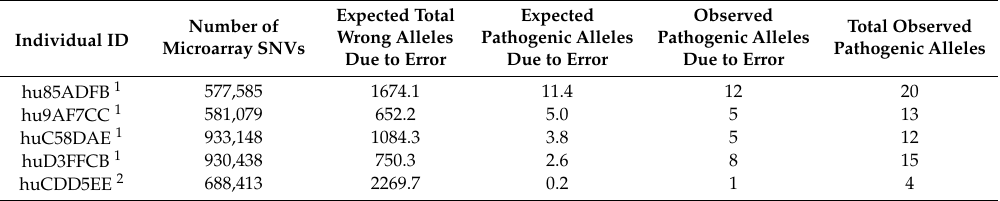
Table 1. Observed and expected pathogenic alleles called due to genotyping